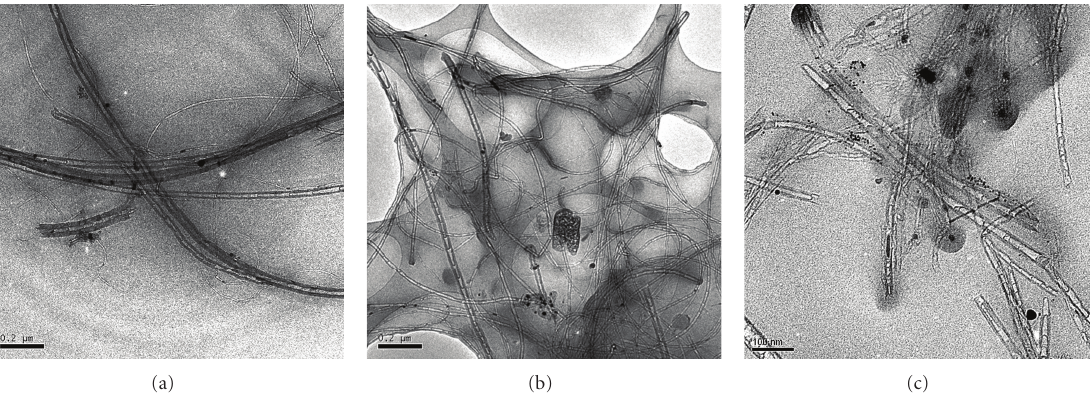
Figure 2: Multiwall carbon nanotubes: (a) modified with Au particles, (b, c) modified with Ti (not evident in the image) after sample preparation procedure for HRTEM.